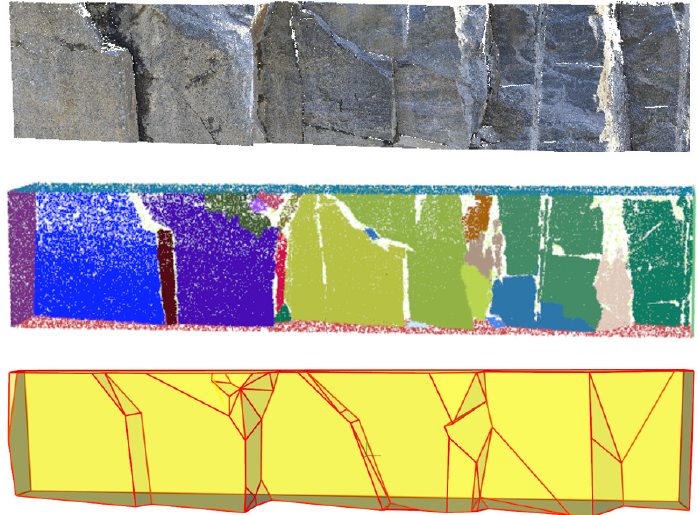
Figure 17. Reconstruction results of Rock 6.